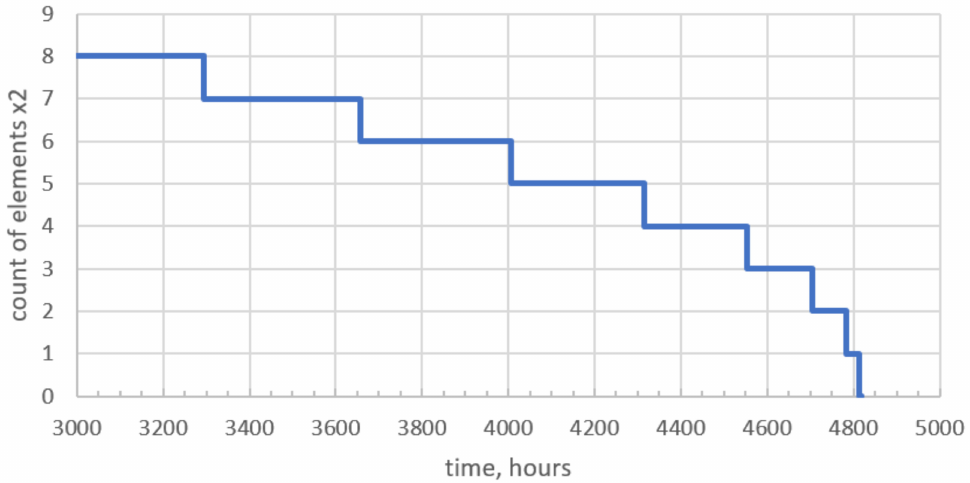
Figure 7. A fragment of a histogram of the hierarchical ramified system’s operation in the course of ( 1 ) = 4, a ( 2 ) = 16. time for a 2 2